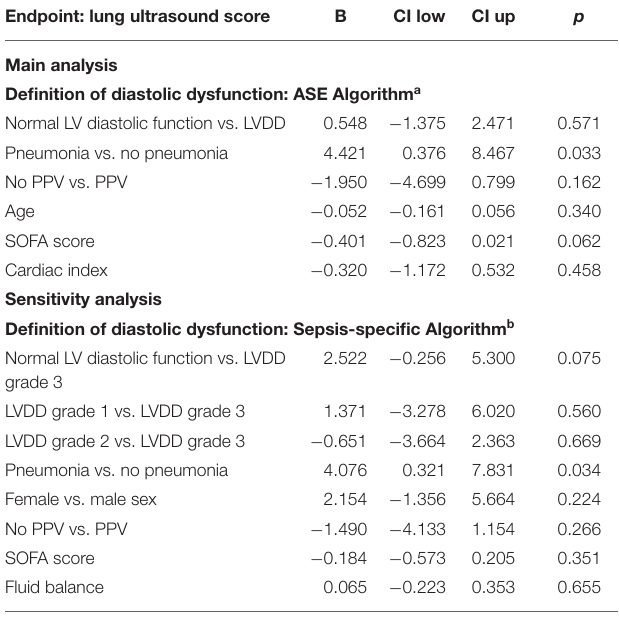
TABLE 3 | Linear mixed models. Endpoint: lung ultrasound